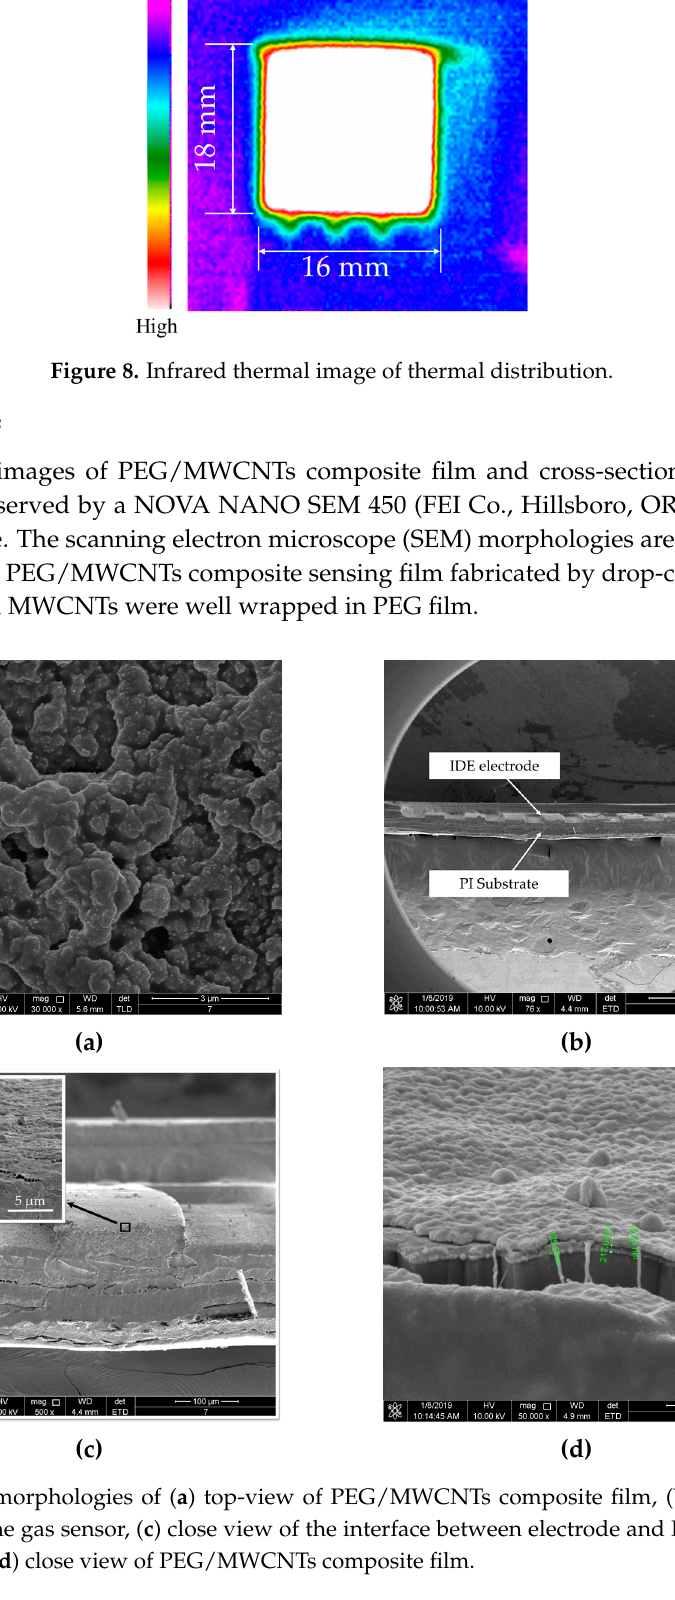
Figure 7. Schematic of the gas sensor equipped with a thermostat. ( a ) front photograph of gas sensor; ( b ) reverse photograph of gas sensor.